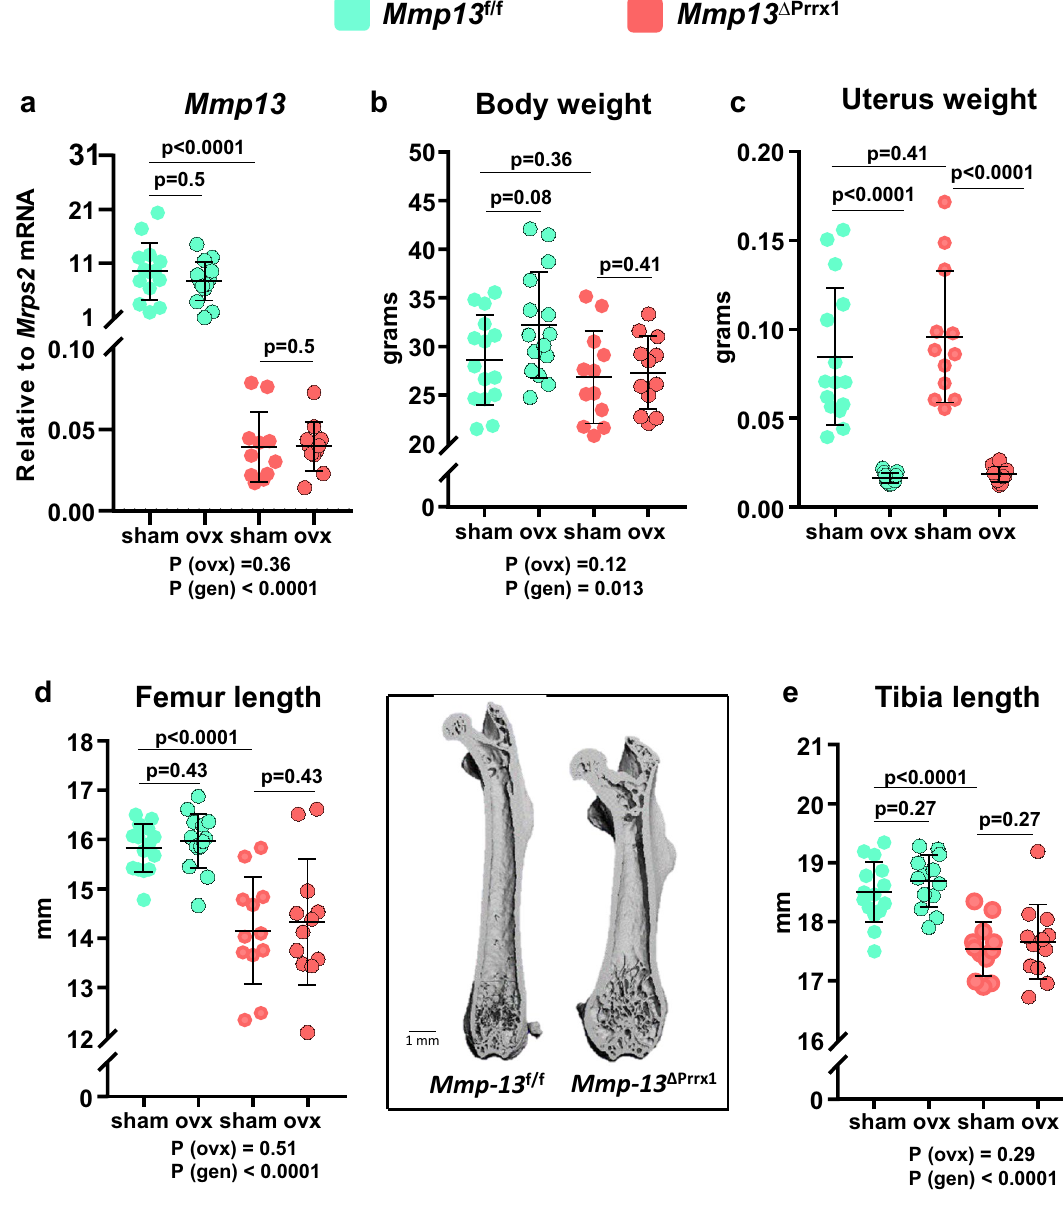
Figure 2. Mmp13 deletion in mesenchymal progenitors decreases the length of both femur and tibia. Female mice with Mmp13 deletion in Prrx1 expressing cells ( Mmp13 ΔPrrx1 ) and control littermates ( Mmp13f. /f ) where either ovariectomized (OVX) or sham-operated (Sham) at 5 months of age and euthanized 8 weeks later. ( a ) Mmp13 relative mRNA expression in femur shafts devoid of bone marrow by qRT-PCR. ( b ) Body weight and ( c ) uterine weight measured at euthanasia. ( d ) Quantification of femur length and representative micro-CT images of longitudinal femur sections of Mmp13f. /f and Mmp13 ΔPrrx1 mice and ( e ) quantification of tibia length. Data represent mean ± S.D. (n = 12–15 mice/group); P values by 2-way ANOVA or Kruskal–Wallis test ( c